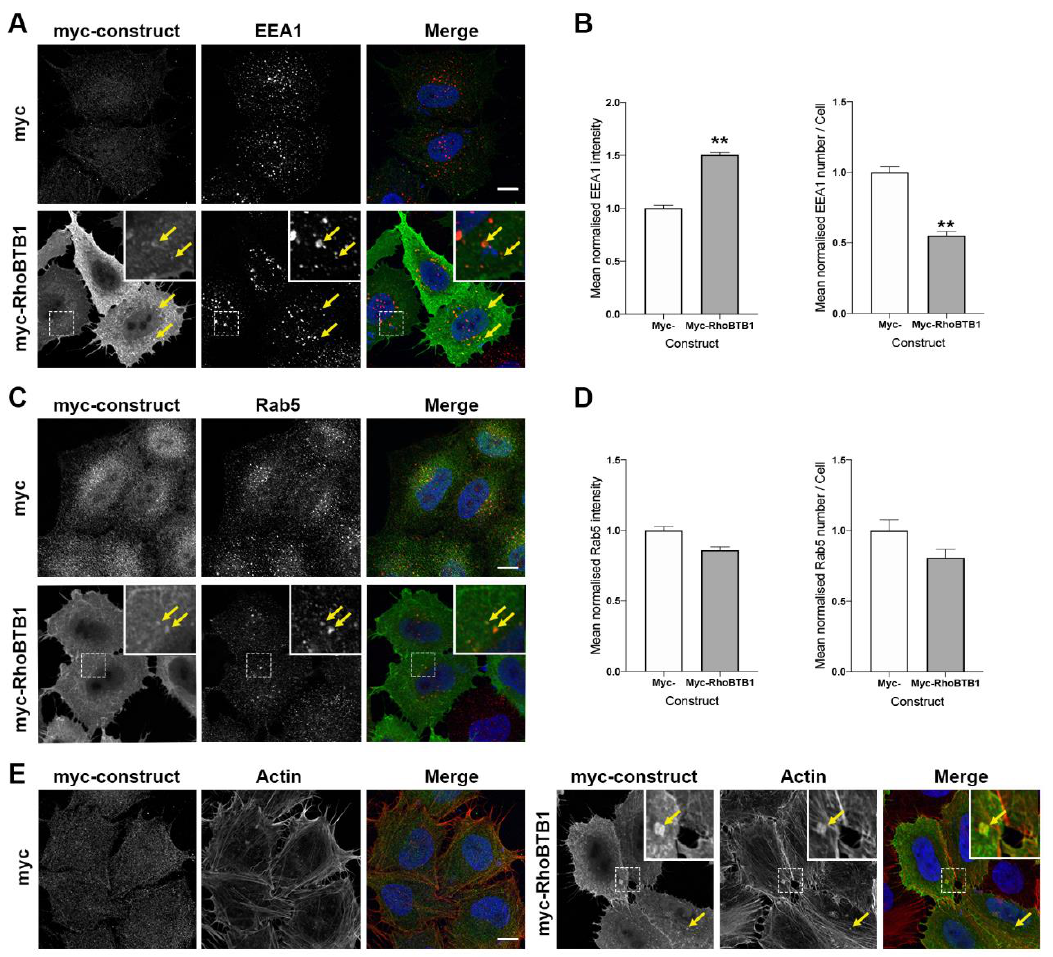
Figure 6. RhoBTB1 localises to early endosomal structures. ( A ) HeLa Kyoto cells overexpressing myc or myc-RhoBTB1 for 18 h were fixed and stained for EEA1. In the merged images, the over-expressed construct is shown in green, EEA1 in red, and the nucleus in blue. Yellow arrows indicate co-localising structures. ( B ) Graphs showing the normalised mean intensity of EEA1 and the normalised mean number of EEA1 structures in overexpressing cells as indicated. Results are presented as mean ± s.e.m. of three independent experiments, with at least 60 cells analysed in total. ** p < 0.01 compared with NEG control cells. ( C ) HeLa Kyoto cells overexpressing myc or myc-RhoBTB1 for 18 h were fixed and stained for Rab5. In the merged images, the over-expressed construct is shown in green, Rab5 in red, and the nucleus in blue. Yellow arrows indicate co-localising structures. ( D ) Graphs showing the normalised mean intensity of Rab5 and the normalised mean number of Rab5 structures in overexpressing cells as indicated. Results are presented as mean ± s.e.m. of three independent experiments, with at least 60 cells analysed in total. ( E ) HeLa Kyoto cells overexpressing myc or myc-RhoBTB1 for 18 h were fixed and stained for actin (phalloidin). In the merged images, the over-expressed construct is shown in green, actin in red, and the nucleus in blue. Yellow arrows indicate co-localising structures. Bars represent 10 μm.